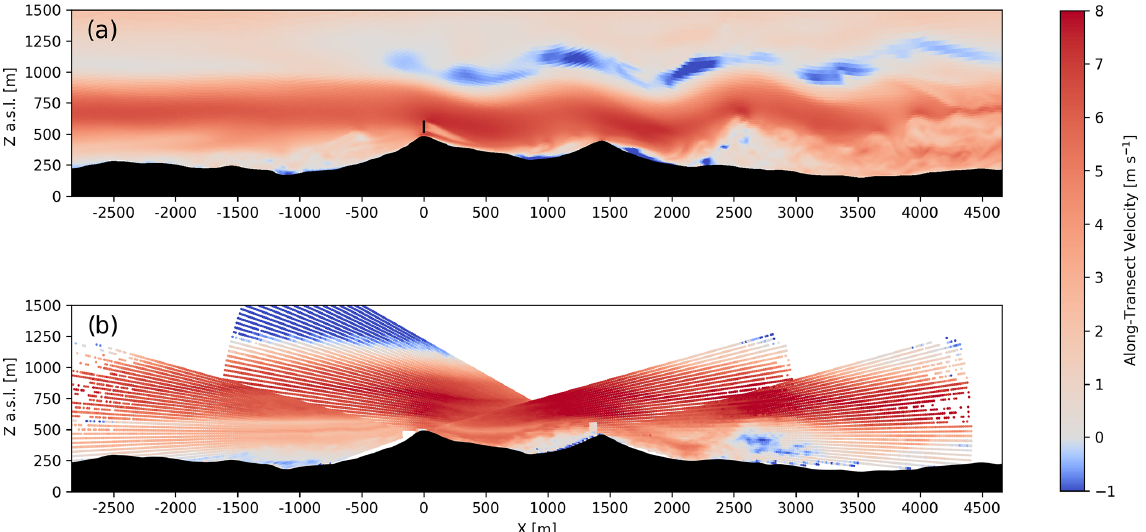
Figure 4. Instantaneous along-transect horizontal velocity during the stable case study for (a) the model and (b) the DTU multi-Doppler lidar scan at approximately 04:20UTC. The output from the model is instantaneous while the multi-Doppler measurements are over the course of a single scan, which takes about 24s. The model transects are aligned with the wake transect and the lidar transects are aligned with the offset transect in Fig. 1. An animation of model results during the entire 2h period is included in the supplementary material (see Video 1 in the Video